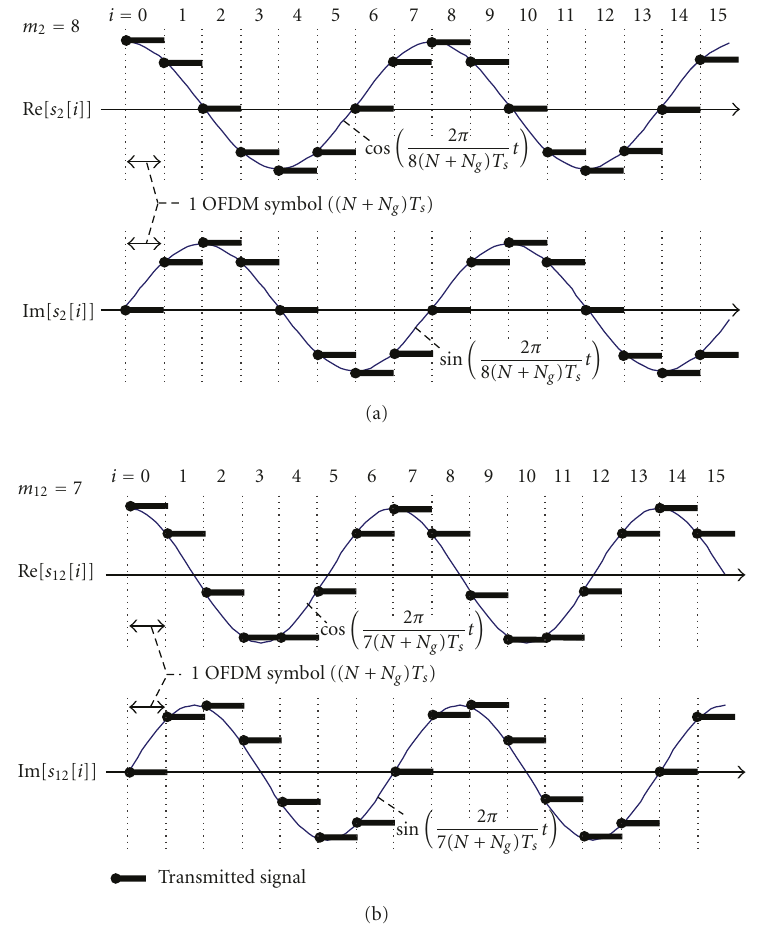
Figure 4: Example of transmitted symbols on dedicated subcarriers.